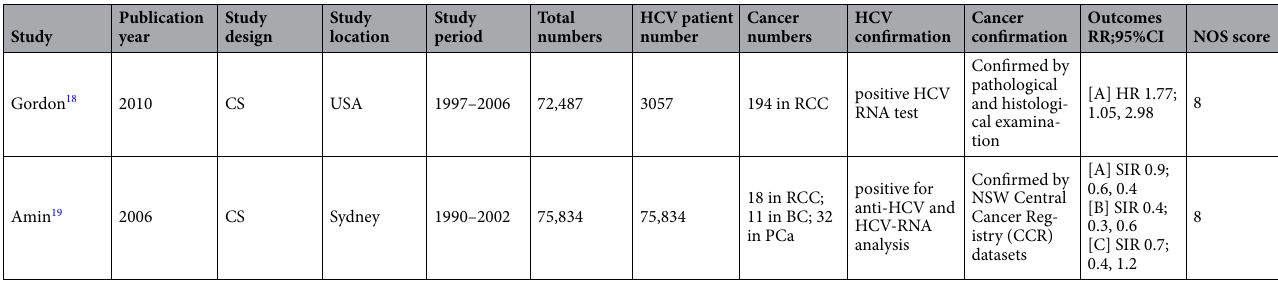
Table 1. Characteristics of studies included in the systematic review and meta-analysis. [A] = kidney cancer; [B] = bladder cancer; [C] = prostate cancer; N/A = not available; HCV = hepatitis C; RCC = renal cell cancer; BC = bladder cancer; PCa = prostate cancer; RR = relative risk; HR = hazard ratio; OR = odds ratio; SIR = standardized incidence ratio; NOS = Newcastle–Ottawa Scale; CS = cohort study; CCS = case–control study; N/A = not available; not evaluated.